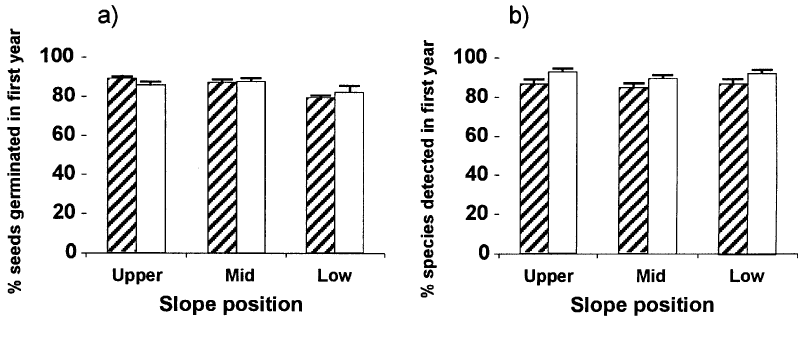
Fig 1. Percentage of seeds a) and species b) by treatments (stripped: control, empty: dung removal) and slope po- sitions detected during the first year cultivation of soil samples. In all cases n = 8. Comparison tests in Tables 1 and